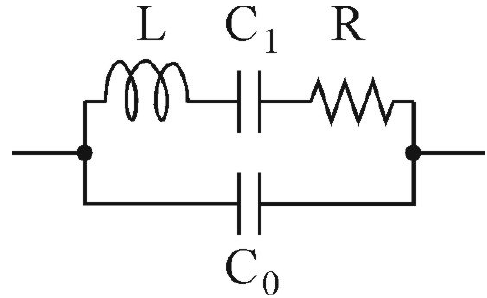
Figure 3. Butterworth–Van Dyke model of a quartz crystal resonator.